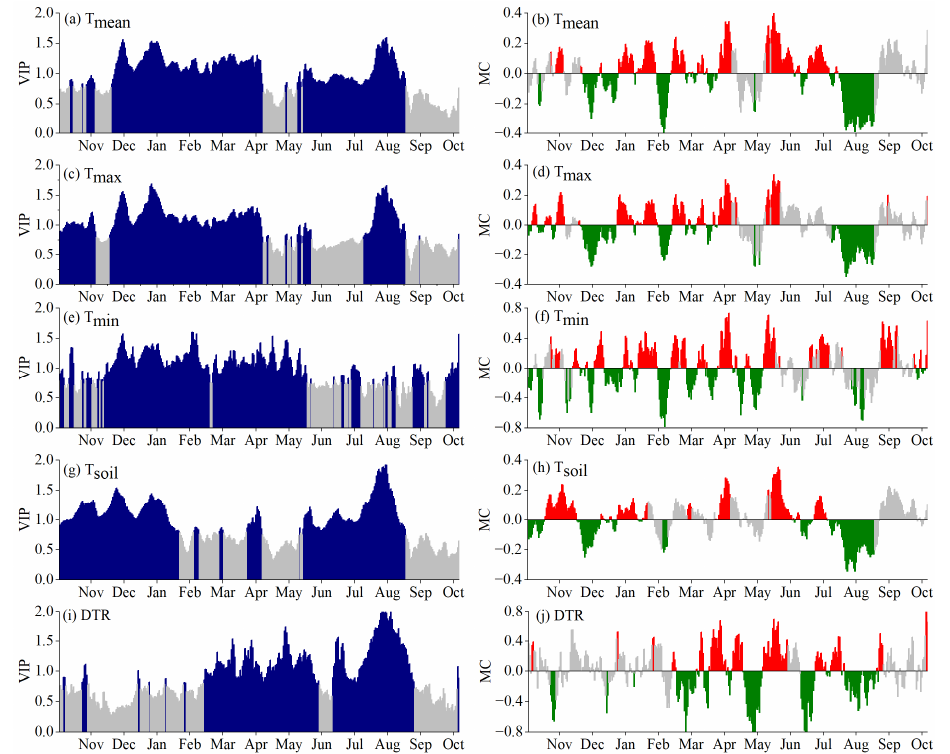
Figure 8. Results of partial least squares (PLS) regression correlating the end of the growing season (EOS) from 1985–2018 with 31-day running means of climatic factors. ( a , b ) Daily mean air temperature (T mean ), ( c , d ) daily maximum air temperature (T max ), ( e , f ) daily minimum air temperature (T min ), ( g , h ) daily soil surface temperature (T soil ) and ( i , j ) diurnal temperature range (DTR) from the previous November to October of the year.